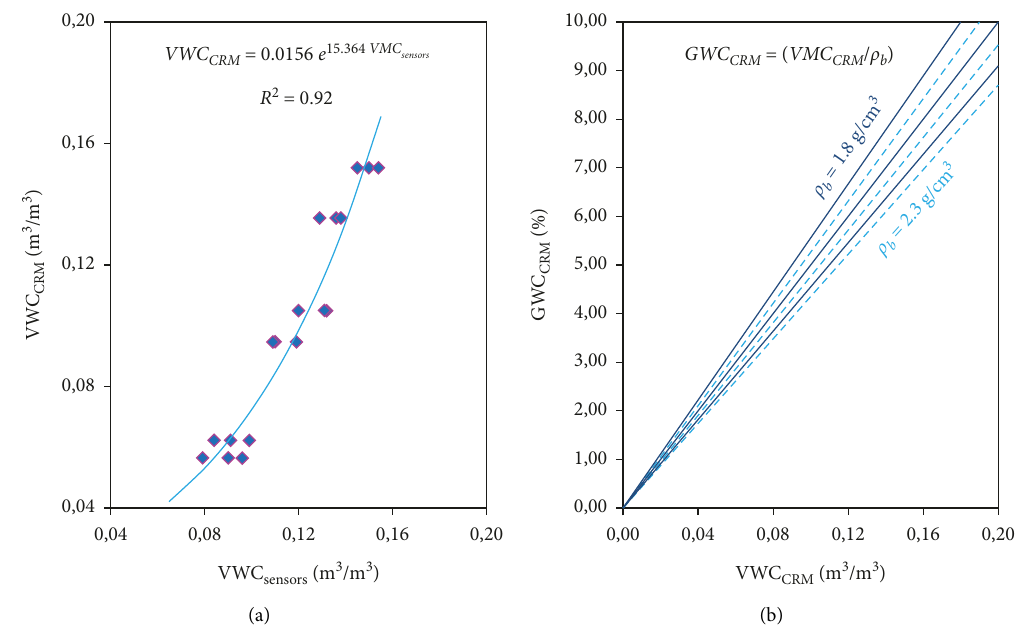
Figure 6: Sensors calibration curves: relationships to obtain (a) the VWC of the CRM from VWC measured by the sensors and (b) the GWC of the CRM from its VWC.